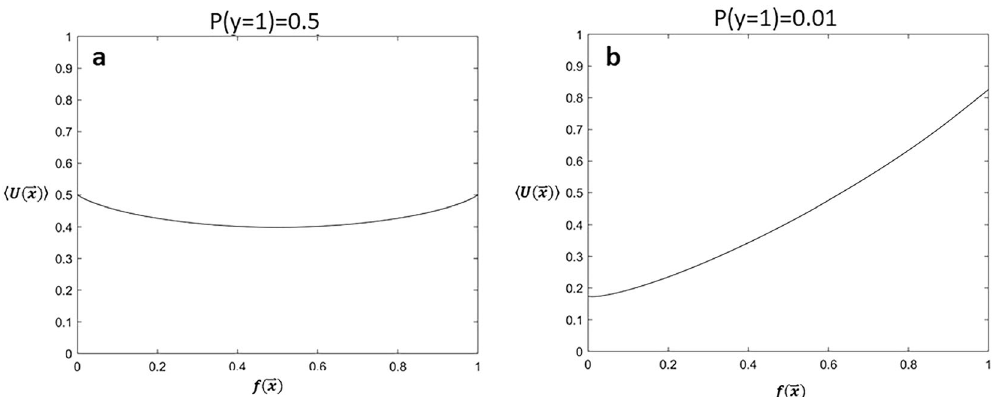
* Þ , when * Þ , in the setting of large class x *